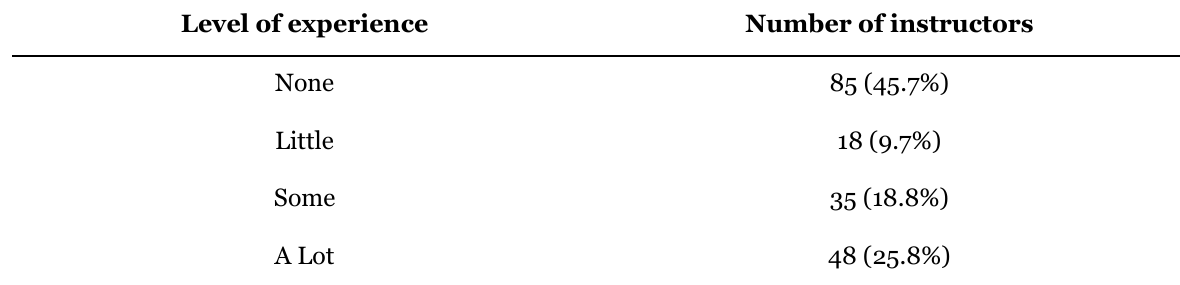
Online Teaching Experience Prior to Teaching First